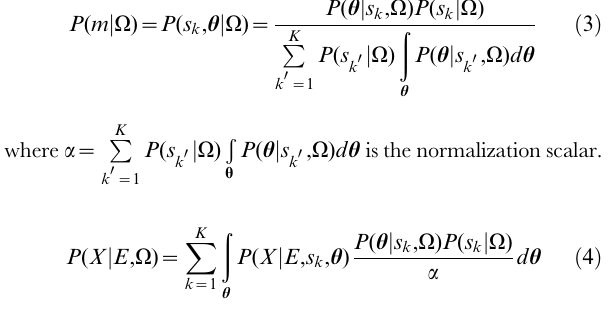
table (CPT) configurations ~ hh k . The BN/DBN model space can be